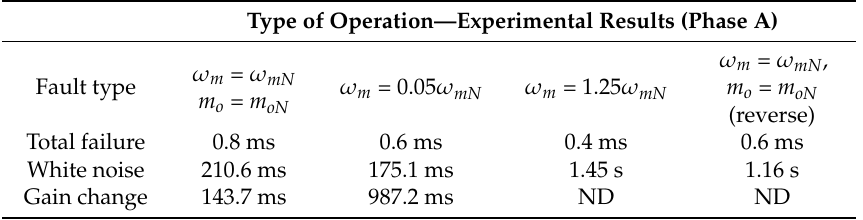
Figure 15. Experimental results of the transients of the output signals from a neural detector during failures of the phase A current transducer: ω m = ω mN , m o = m oN ( a , d , g ), ω m = 0.05 ω mN ( b , e , h ), ω m = ω mN , m o = m oN reverse operation ( c , f , i )—total failure of the sensor ( a , b , c ), white noise ( b , c , d ) and gain change ( g , h , i ). Table 2. Experimental results of detection times ∆ t (ms) of the current sensor fault in phase A for a NN fault detector (Direct Field Oriented Control structure).